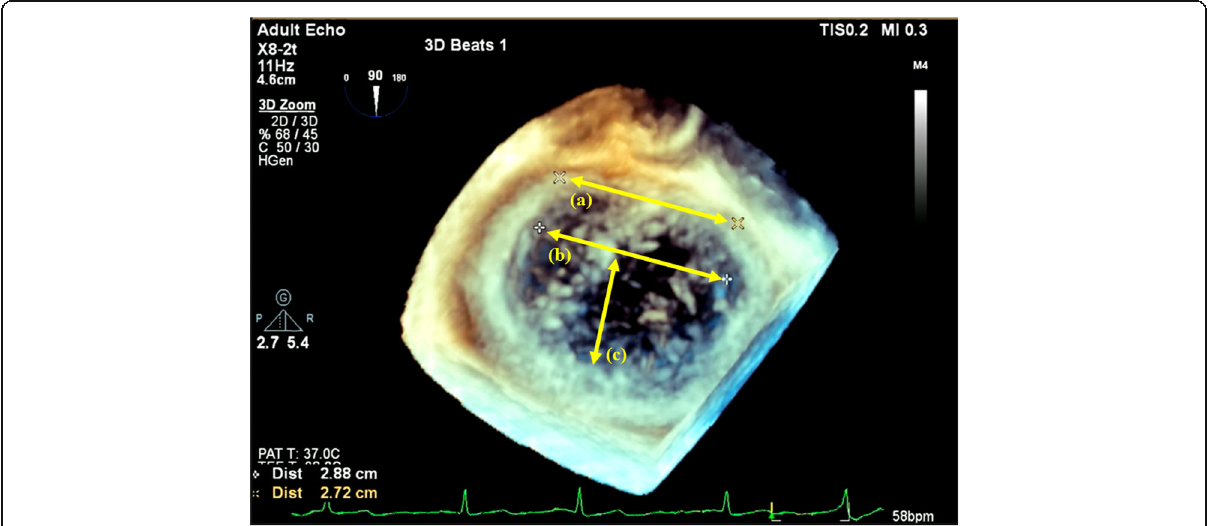
Fig. 1 Sizing of the mitral valve when treating Barlow ’ s disease was performed using three-dimensional TEE at the end of systole. The optimal ring size was determined mainly with reference to the intercommissural (IC) distance. When changing the predetermined ring size, the height of the A2 segment of the anterior leaflet (A-height) was considered. In cases with a short A-height and long IC, size was determined by considering the intertrigonal (IT) distance, longitudinal diameter (LD), and transverse diameter (TD). Abbreviations: TEE, transesophageal